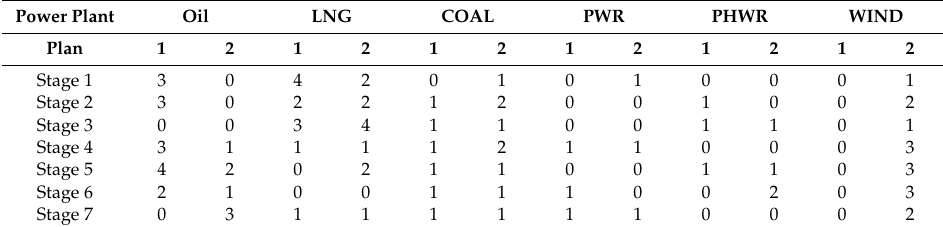
Table 10. Selected optimal plans with the least-cost function, in the presence of wind farm (plan 1) and in the presence of a wind farm (plan 2).